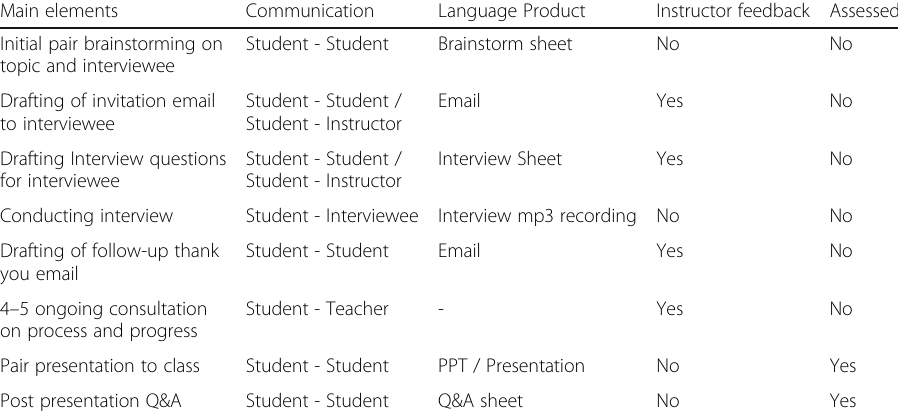
Table 1 PBLT project main